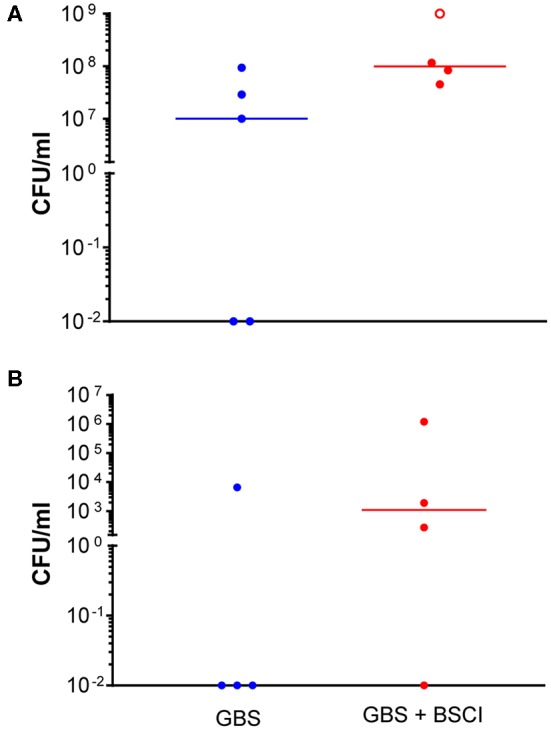
Increased GBS bacterial burden in the amniotic fluid and fetal blood of BSCI-treated animals. GBS CFU are shown in amniotic fluid (A) and fetal blood (B) obtained at Cesarean section. Animals inoculated with GBS are shown as solid blue circles and those inoculated with GBS but also given BSCI are shown as solid red circles. One animal treated with the BSCI and inoculated with GBS was also found to have a contaminating bacteria (S. epidermis) within the amniotic fluid, which complicated estimation of the GBS CFU; this animal is represented by an open red circle.